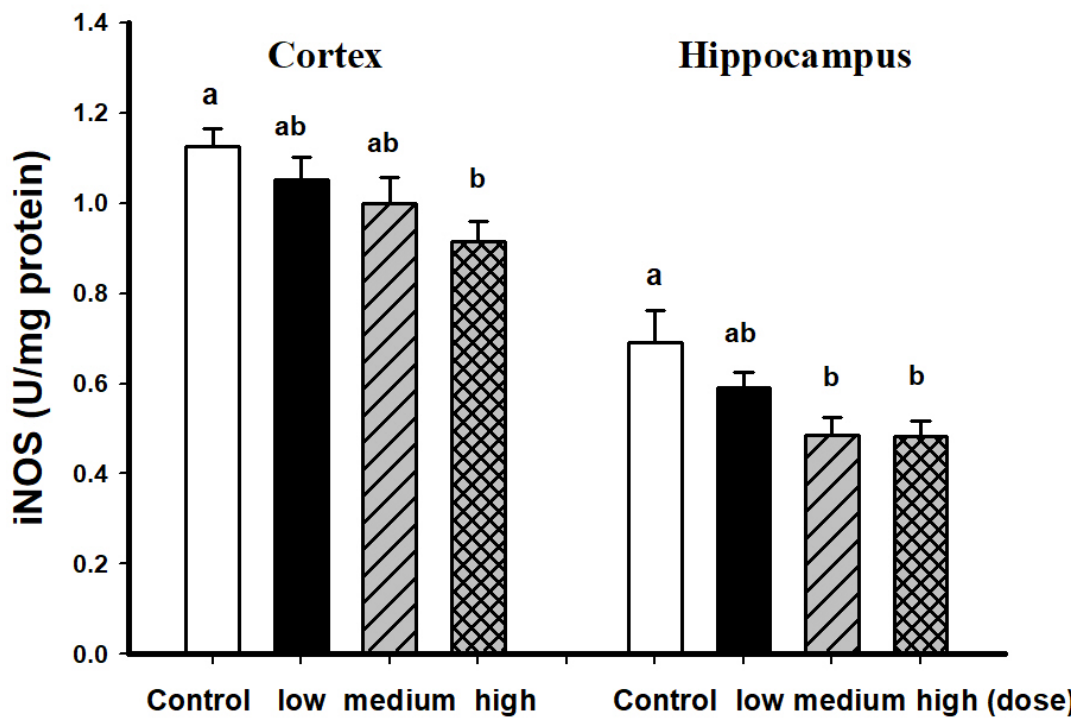
Figure 4. iNOS activity in female mice brain fed after 13 weeks feeding. Low dose group (108 mg/kg/bw/day), intermediate dose group (215 mg/kg/bw/day), high dose group (431 mg/kg/bw/day). Values are expressed as mean ± S.E.M. and analyzed by one-way ANOVA ( n = 5). Groups with different letters denote significant difference between each group ( p < 0.05).